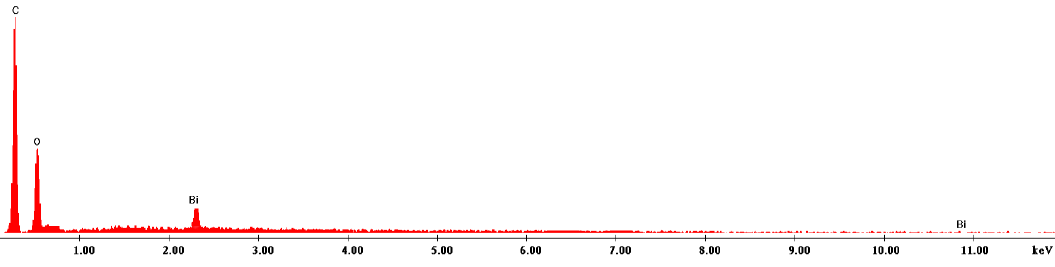
Figure 4. Energy dispersive X-ray spectroscopy, EDX obtained for sample BCb/CB.